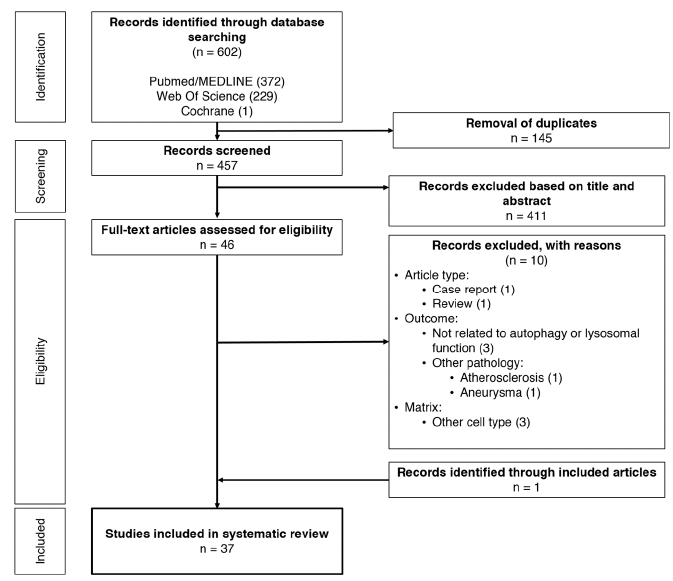
Figure 2. Review workflow.